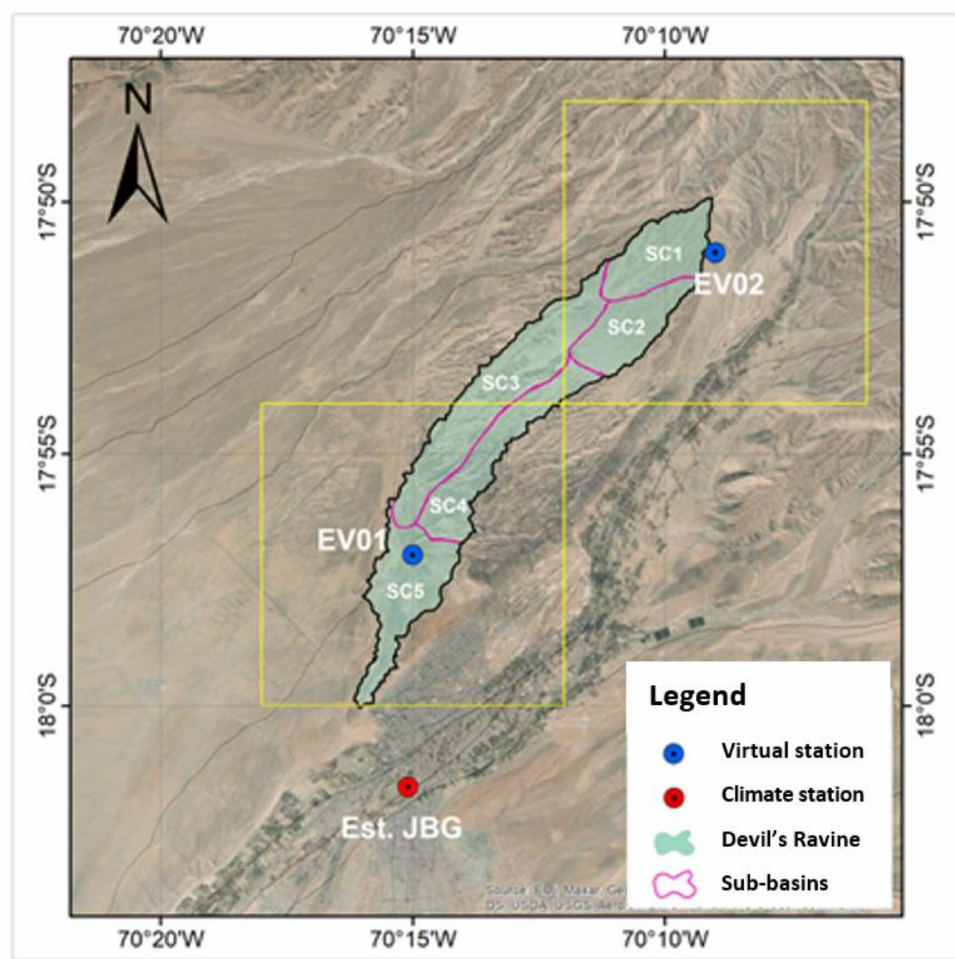
Figure 7. Location of virtual rain gauges and the JORGE BASADRE rain